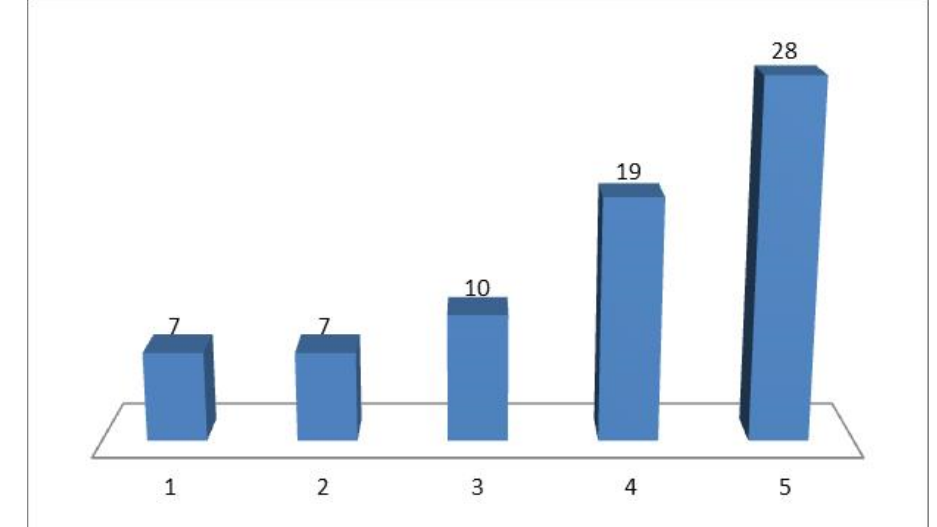
Figure 9. Causes for reduced local interest in WrGIs / SuDSs: ( 1 ) traditional systems are reliable and recognised; ( 2 ) the long-term maintenance costs of WrGIs / SuDSs are considered problematic; ( 3 ) the construction costs of WrGIs / SuDSs are considered higher than those of the grey infrastructures; ( 4 ) little general interest in the area for WrGIs / SuDSs; ( 5 ) there is interest in WrGIs / SuDSs in the area.